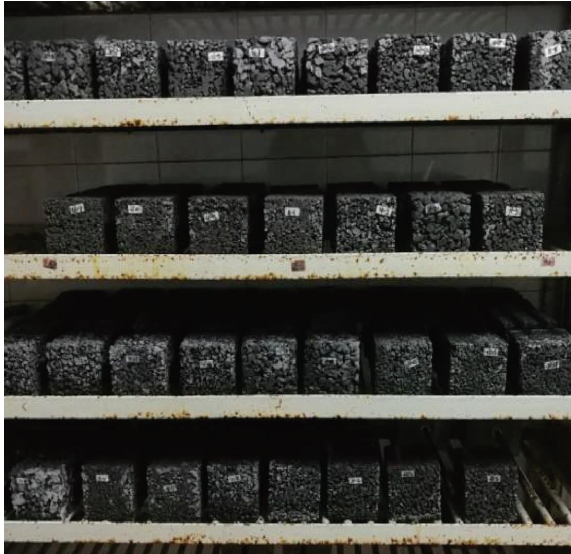
Figure 6: Conservation diagram of specimen curing